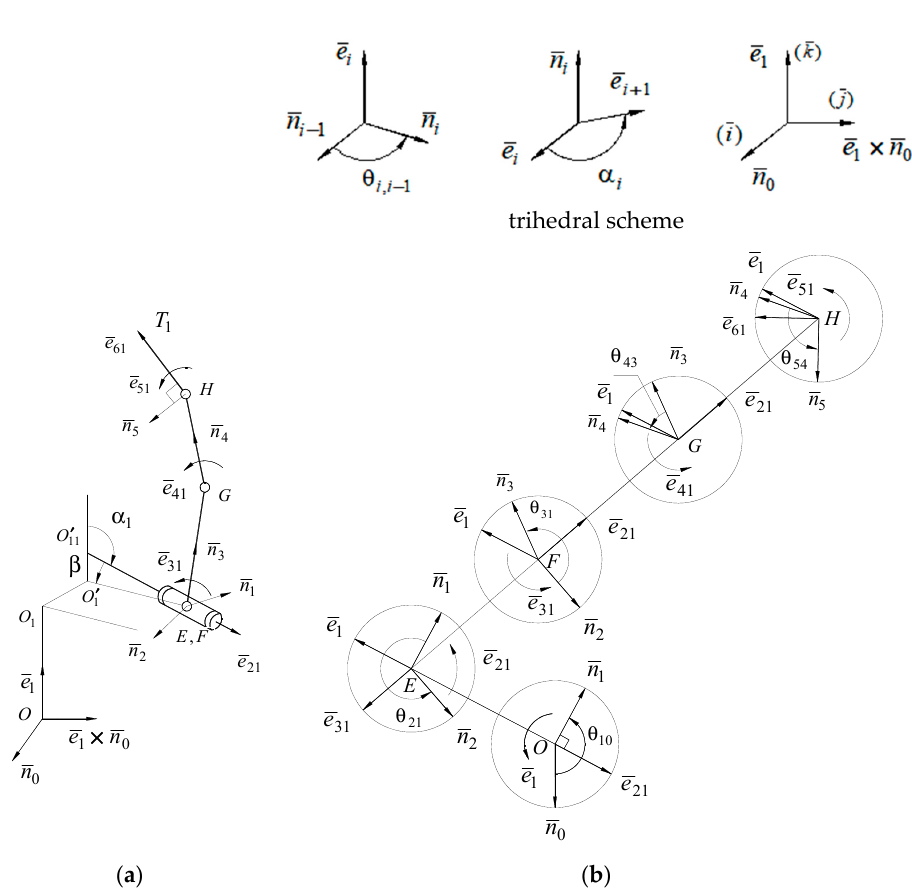
Figure 2. Schemes of the designed index finger mechanism: ( a ) kinematic scheme, ( b ) versorial scheme.